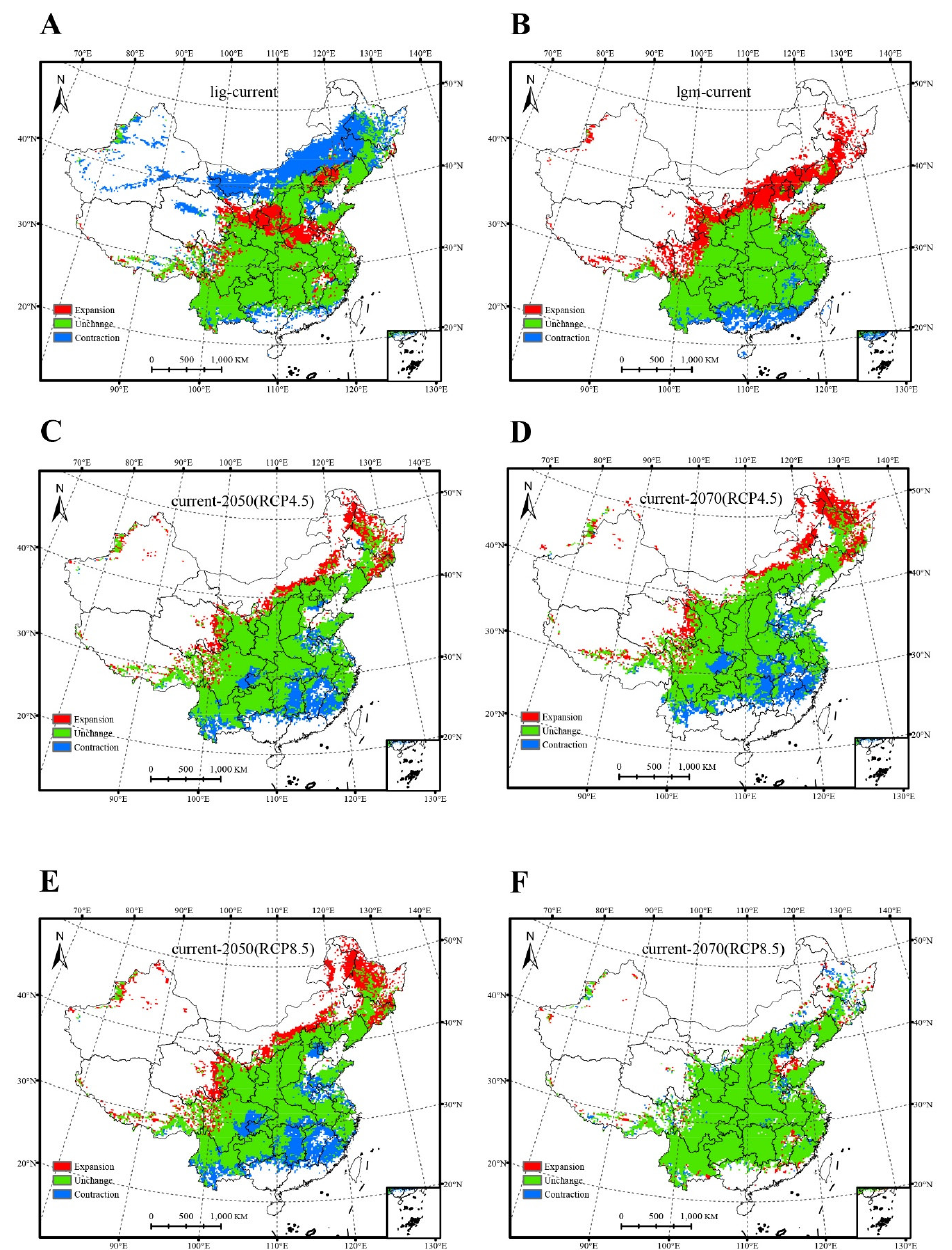
Figure 2. Spatial changes of Salicaceae plants in China under different combinations of climate scenario/years (Albers projection). Comparisons between the species distribution model (SDM) for Salicaceae in the present and ( A ) the SDM under the Last Inter Glacial (“lig”); ( B ) the SDM under the Last Glacial Maximum (“lgm”); ( C ) the SDM under future climate scenario RCP4.5 in 2050; ( D ) the SDM under future climate scenario RCP4.5 in 2070; ( E ) the SDM under future climate scenario RCP8.5 in 2050; ( F ) the SDM under future climate scenario RCP8.5 in 2070. The map was plotted in ArcGIS